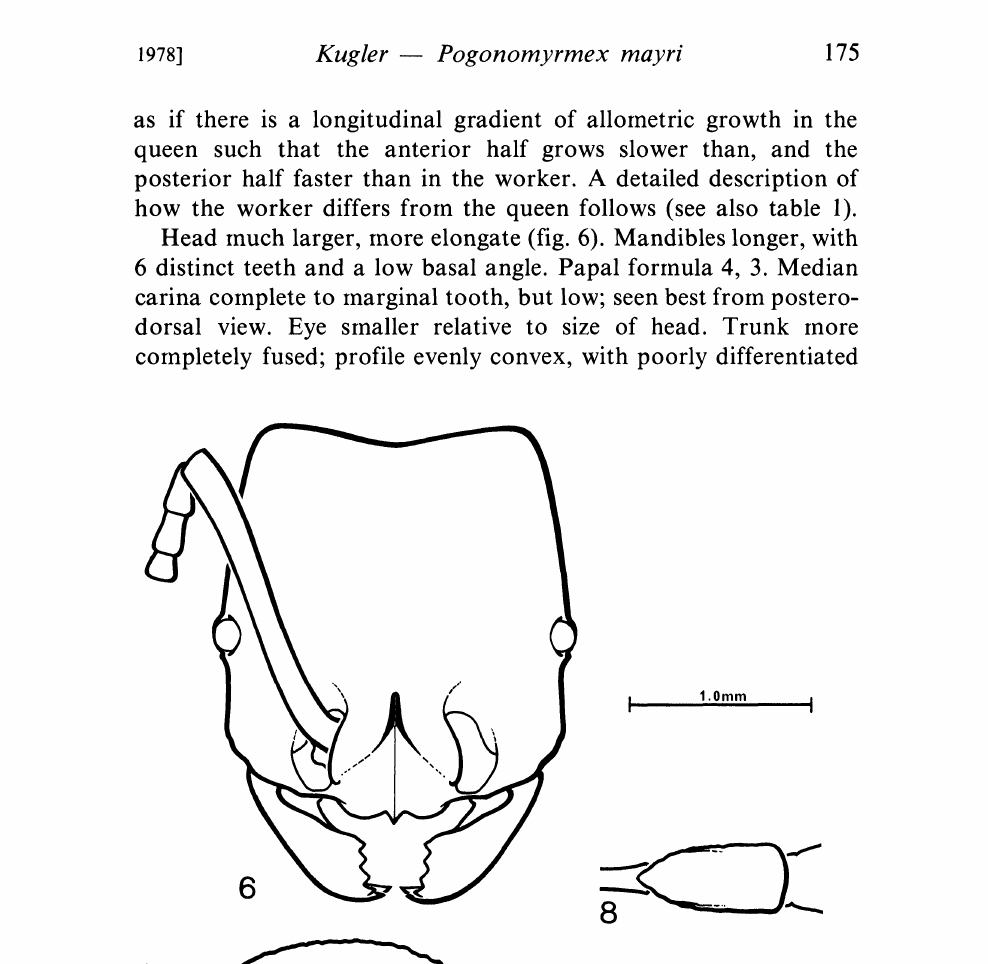
Figs. 6-8. Worker of P. mayri. Fig. 6, head in full dorsal view. Fig. 7, trunk and petiole in lateral view. Fig. 8, dorsal view of